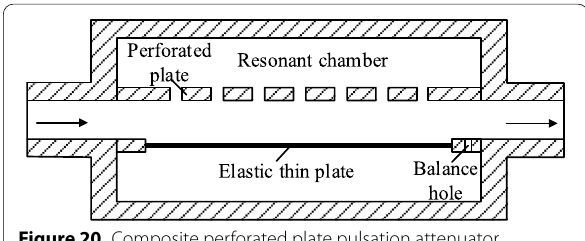
Figure 20 Composite perforated plate pulsation attenuator